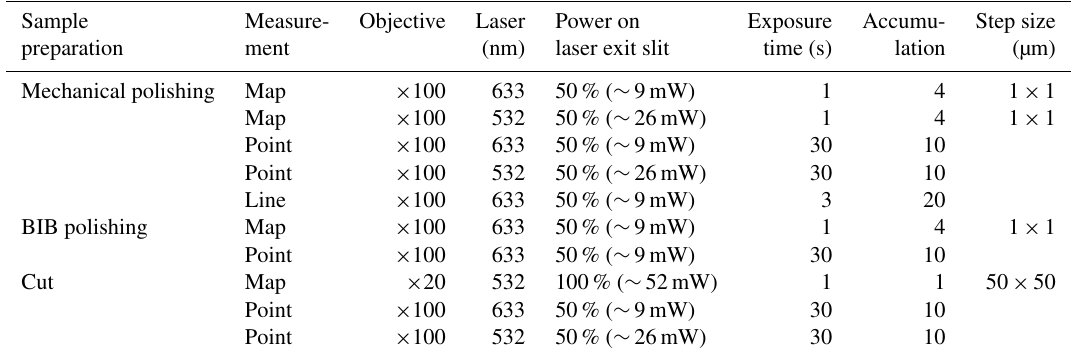
Table 1. Measurement settings.